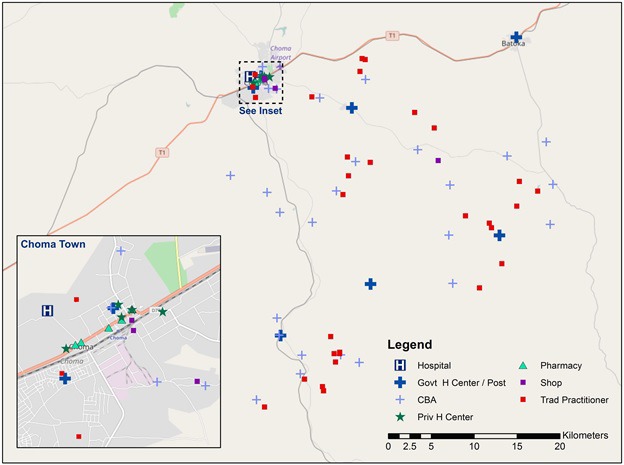
Map of health care provider locations.